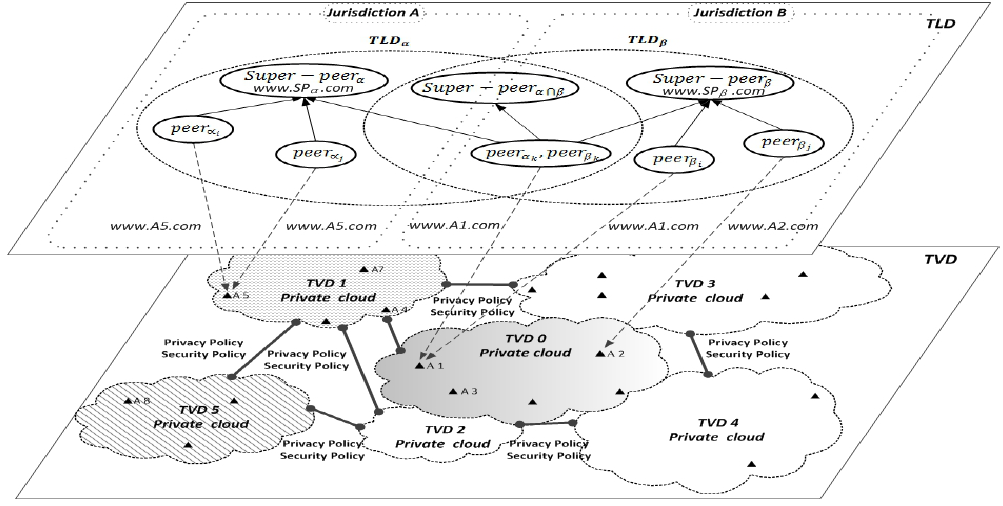
Figure 1. Law-aware semantic policy infrastructure, where a TLD is a legal cage, designated as an SPD, to circumscribe the legal virtual boundary of data disclosure and usage. A TVD is a logical cage that provides security and privacy policies, corresponding to semantic legal